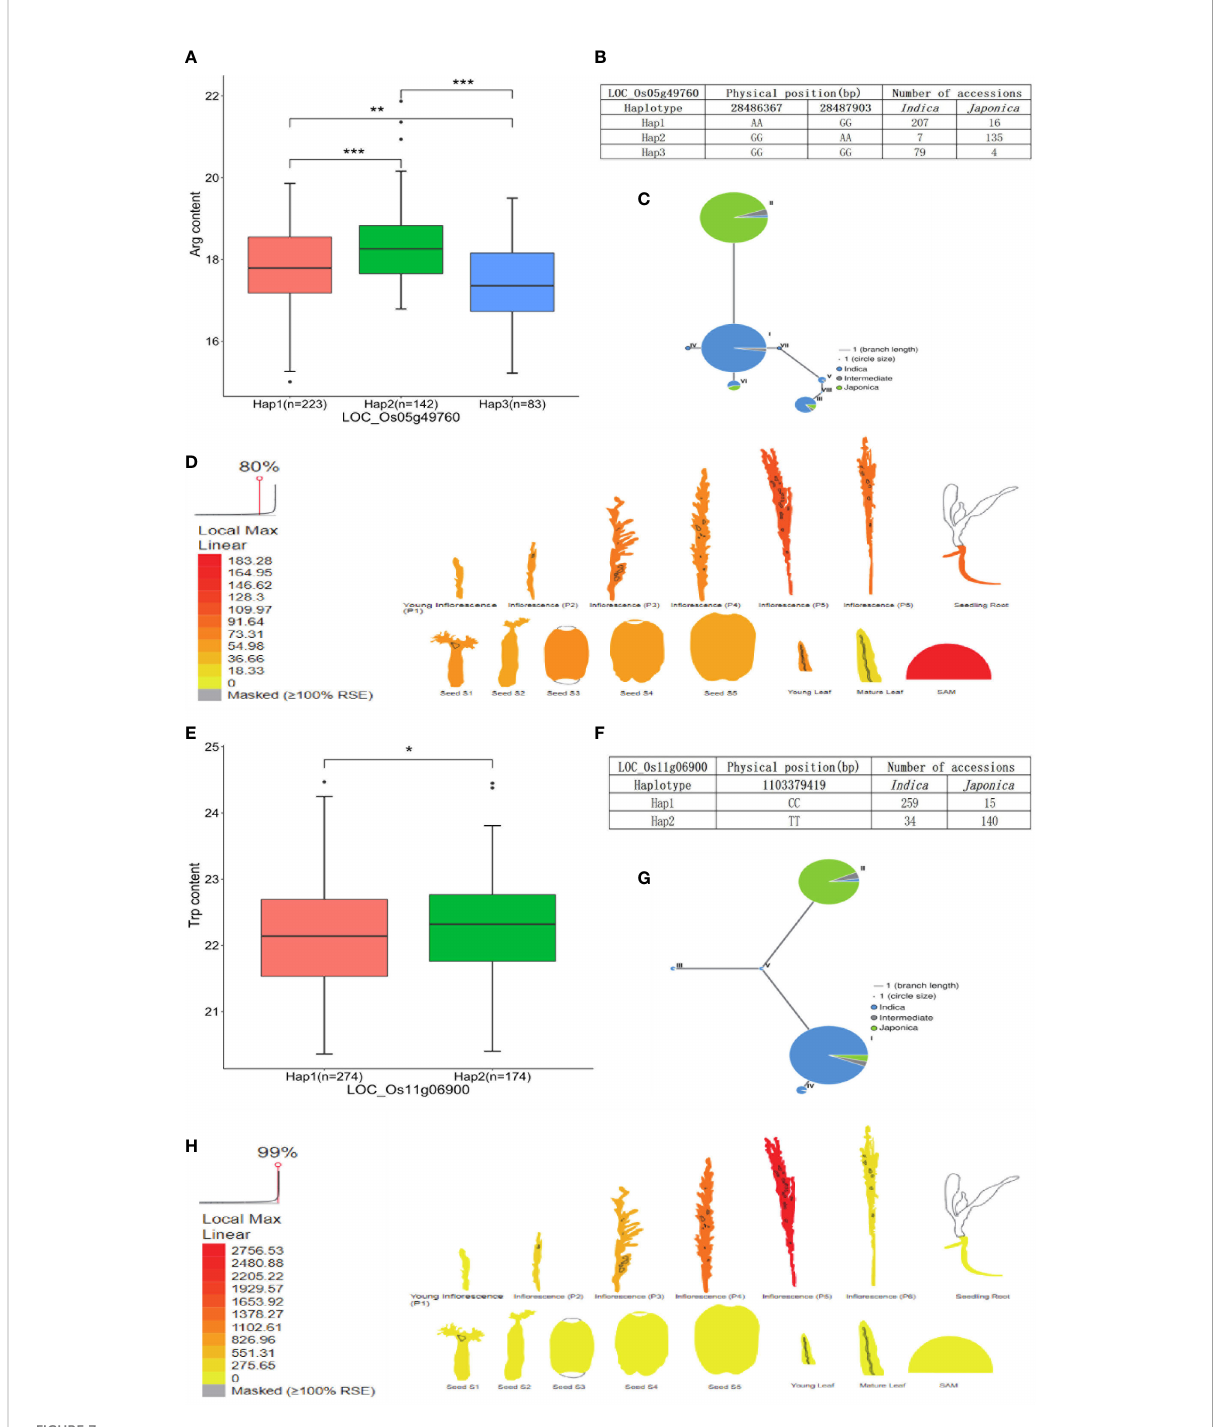
FIGURE 7 Analyses of Arg level associated gene LOC_Os05g49760 and Trp level associated gene LOC_Os11g06900 . (A) Signi fi cant tests between three haplotypes of LOC_Os05g49760 and Arg contents. (B) Three haplotypes of LOC_Os05g49760 and their distribution in indica and japonica accessions. (C) Haplotype network of LOC_Os05g49760 . (D) Expression pro fi le of LOC_Os05g49760 based on ePlant transcriptome analysis in rice, expression strength coded by color from yellow (low) to red (high). (E) Signi fi cant tests between two haplotypes of LOC_Os11g06900 and Trp contents. (F) Three haplotypes of LOC_Os11g06900 and their distribution in indica and japonica accessions. (G) Haplotype network of LOC_Os11g06900 . (H) Expression pro fi le of LOC_Os11g06900 based on ePlant transcriptome analysis in rice, expression strength coded by color from yellow (low) to red (high). *, **, and *** indicate statistical signi fi cance at the 5%, 1%, and 0.1% probability level,